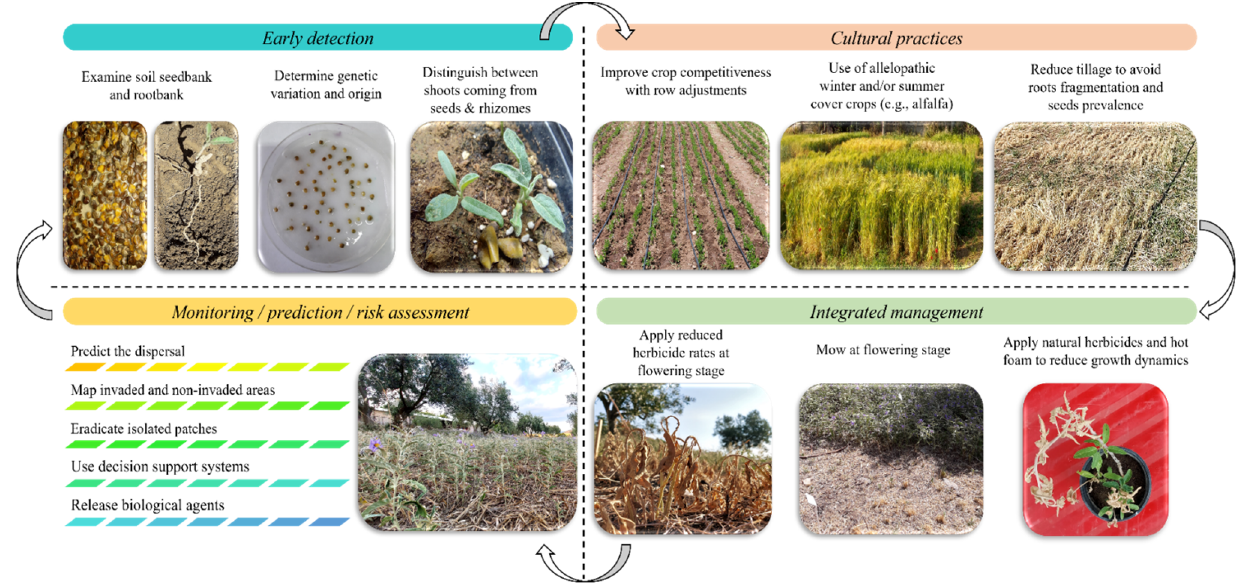
Figure 3. A conceptual framework for the integrated management of Solanum elaeagnifolium